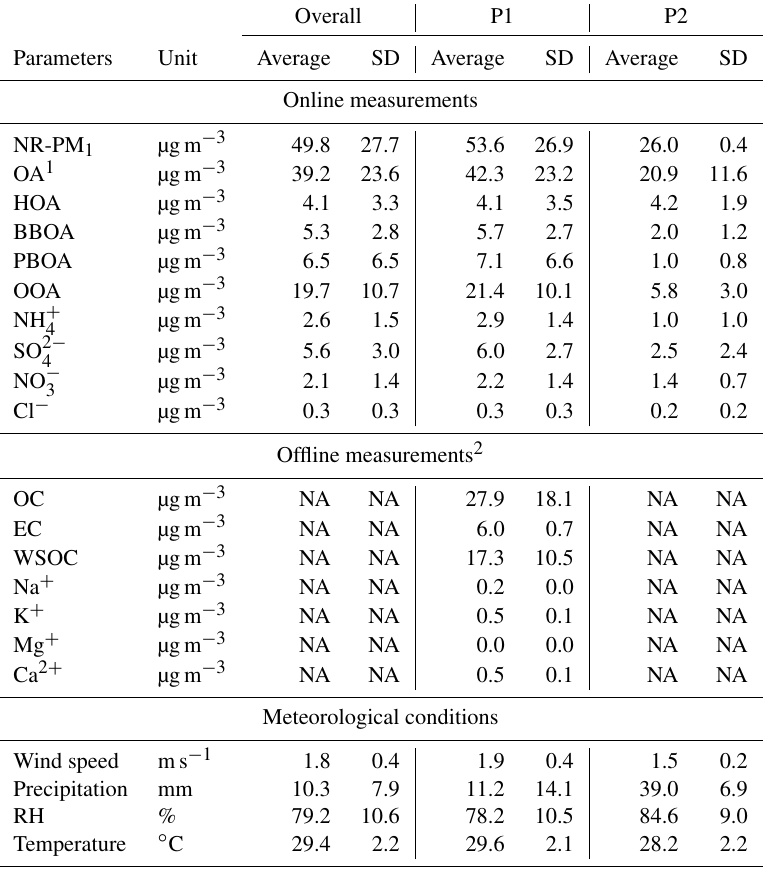
Table 1. Average concentrations with 1 standard deviation (SD) of chemical species measured during the October 2015 haze episode in Singapore using ToF-ACSM (online) and integrated filter samples (offline) measurements. Wind speed and precipitation data were retrieved from the website of the Meteorological Service Singapore, and other meteorological parameters were from measurement at the sampling